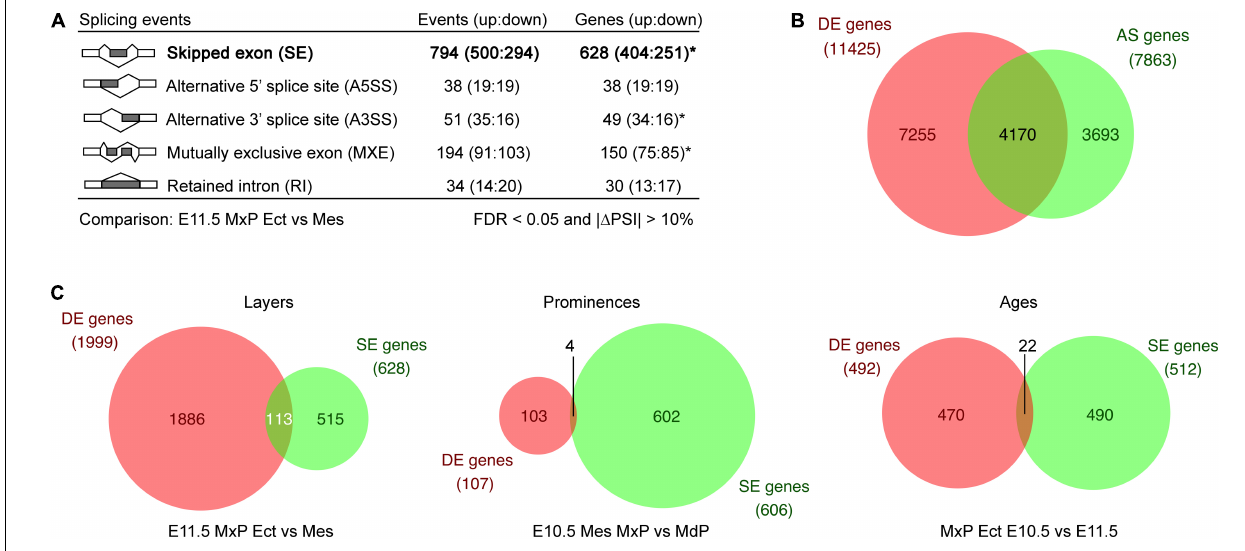
FIGURE 2 | Alternative splicing program during facial development. (A) Alternative splicing events called by rMATS by categories from comparison between E11.5 MxP ectoderm and mesenchyme with cutoffs as FDR < 0.05, | (cid:49) PSI| > 10%, and at least one sample with five inclusion read counts or skipping read counts. For the diagrams of the five types of alternative splicing events, dark gray rectangles are the alternative used exons or the retained intron, while white rectangles are the conserved exons. Lines indicate splicing. Asterisks indicate that some of the genes have both up events or down events. (B) Many genes are regulated only by differential alternative splicing during facial development. Venn diagram showing the comparison between differentially expressed (DE) genes and differentially used alternatively spliced (AS) genes during facial development across all tissues. (C) Venn diagrams of individual layer, prominence, or age comparisons demonstrate there are few overlaps between DE and SE genes. AS, alternative splicing; DE, differentially expressed; Ect, ectoderm; Mes, mesenchyme; MdP, mandibular prominence; MxP, maxillary